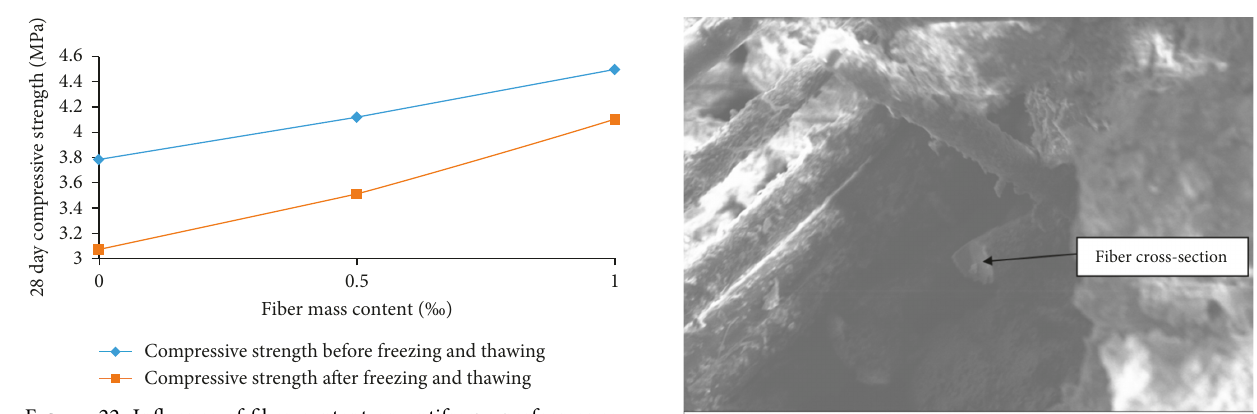
Figure 22: Influence of fiber content on antifreeze performance.